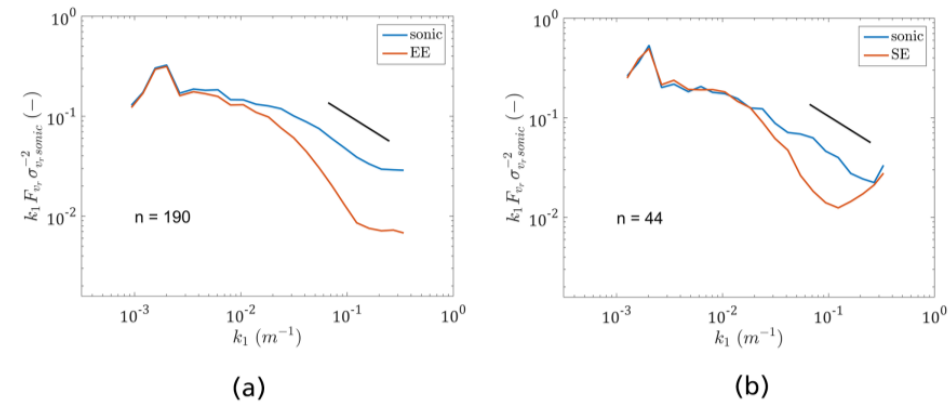
Figure 3. Variance of the radial velocity measurements of the WindScanners (cid:4672)(cid:1874) (cid:4593) (cid:3045) (cid:2870) respective variance in the direction of the beam derived from the sonic anemometer (cid:4672)(cid:1874) (cid:4593) (cid:3045) (cid:2870) the wind direction was close to parallel (±15°) to the azimuth angle of the WindScanner for ( a ) SE; ( b ) SW; ( c ) EE; grey diamonds indicate the unfiltered sonic measurements; blue crosses are the sonic data after the application of (10). The sonic data was filtered with (cid:3627)(cid:2014)(cid:4632)((cid:1863) (cid:2869) )(cid:3627) temporal averaging.